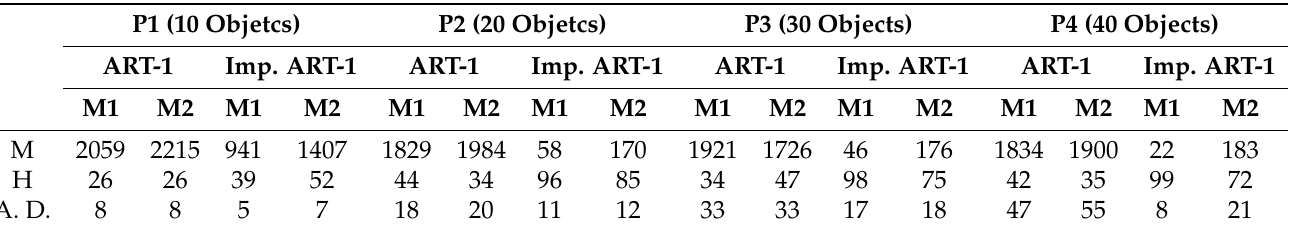
Table 2. Comparison between binary conversion method-1 and method-2 for four different problem sizes considering ART-1 and Improved-ART-1. Here, M = misclassification, H = homogeneity, A.D. = Average Distance